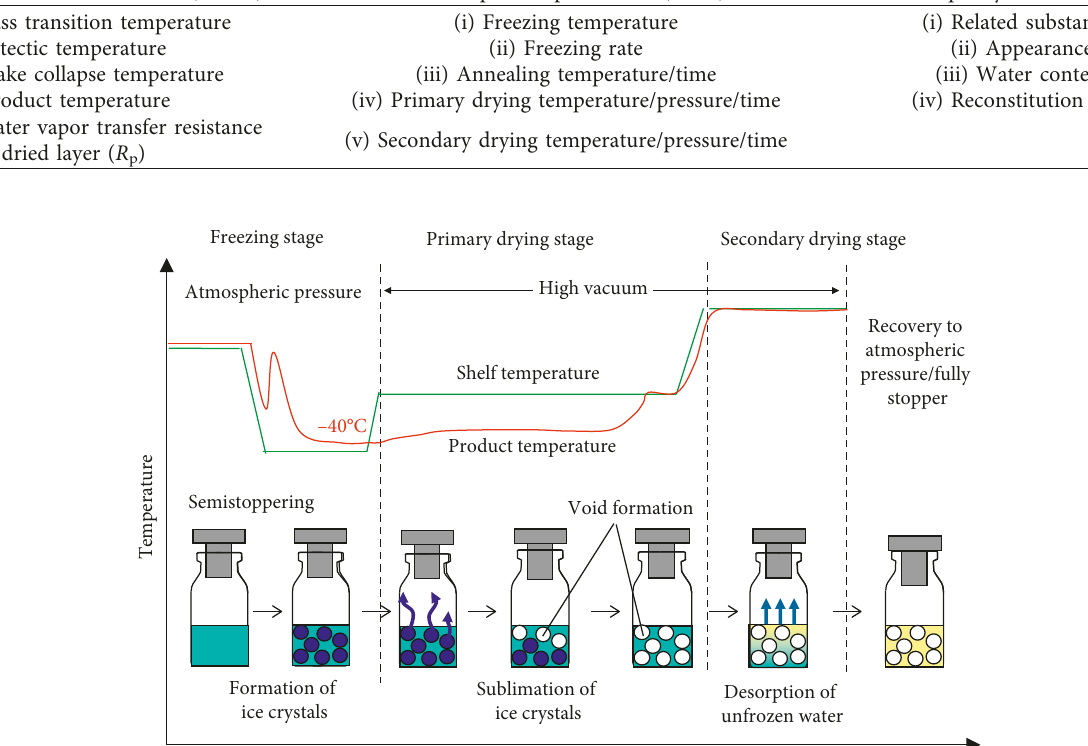
Table 1: Potential critical material attributes, critical process parameters, and critical quality attributes. Critical material attributes